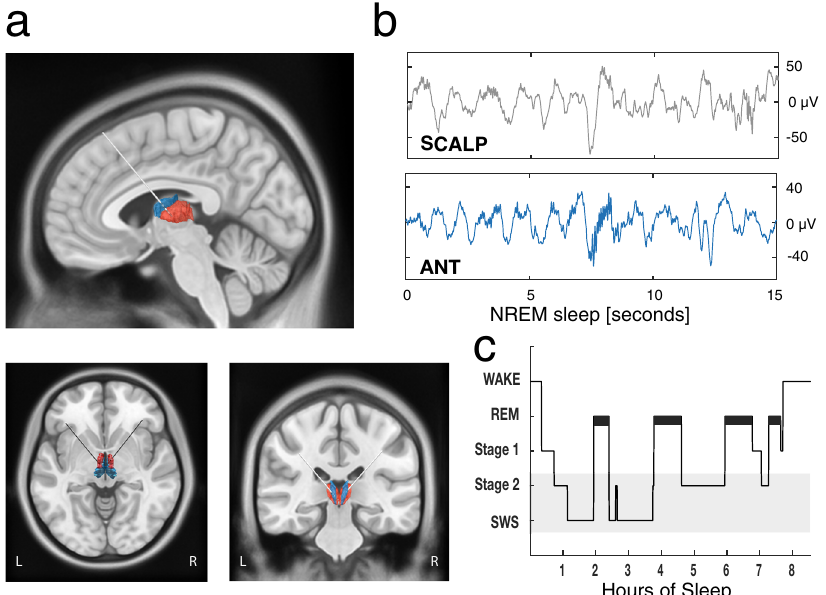
Fig. 1 | Thalamic electrode placement and sleeparchitecture.a Electrodes were implantedintheleftandrightANT(blue)andMD(red).Localizationofanexemplar patient ’ s DBS leads (ref. 71) is shown on a T1-weighted template MRI with super- imposed thalamus atlas (ref. 74). b Example of NREM sleep segment (15s),